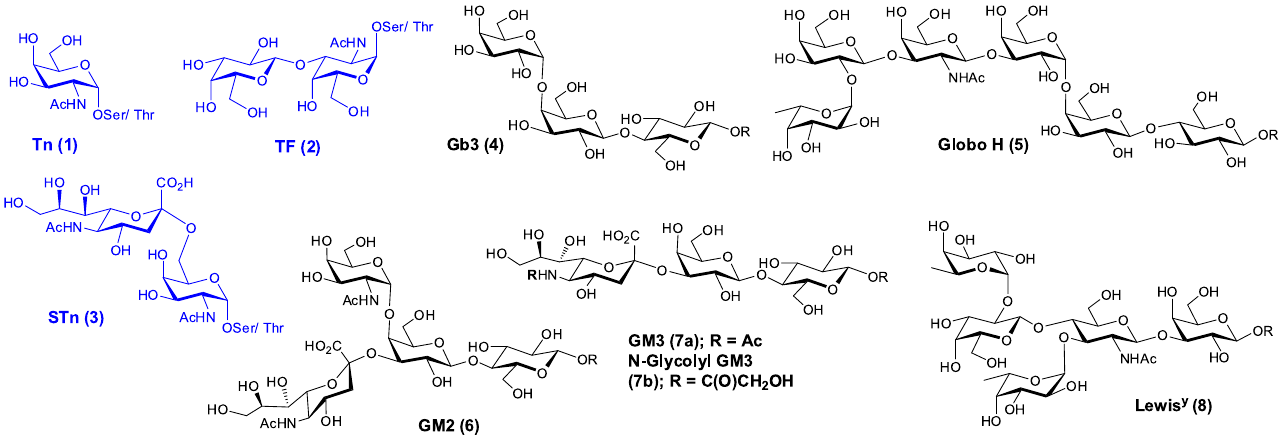
FIGURE 3 - Typical structures of representative TACAs from glycoproteins (blue) and glycolipids accumulated on cancer